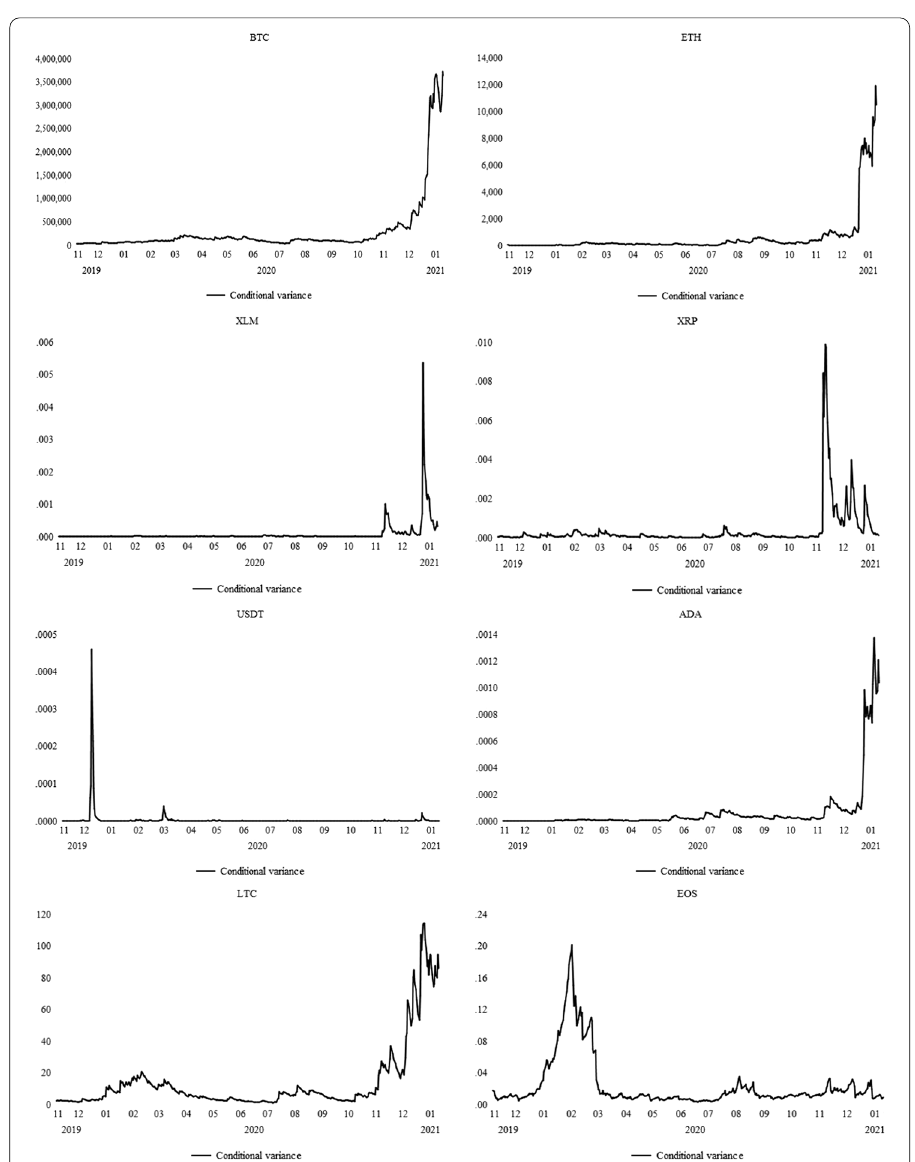
Fig. 15 Conditional variances. Source : CoinDesk, Authors’